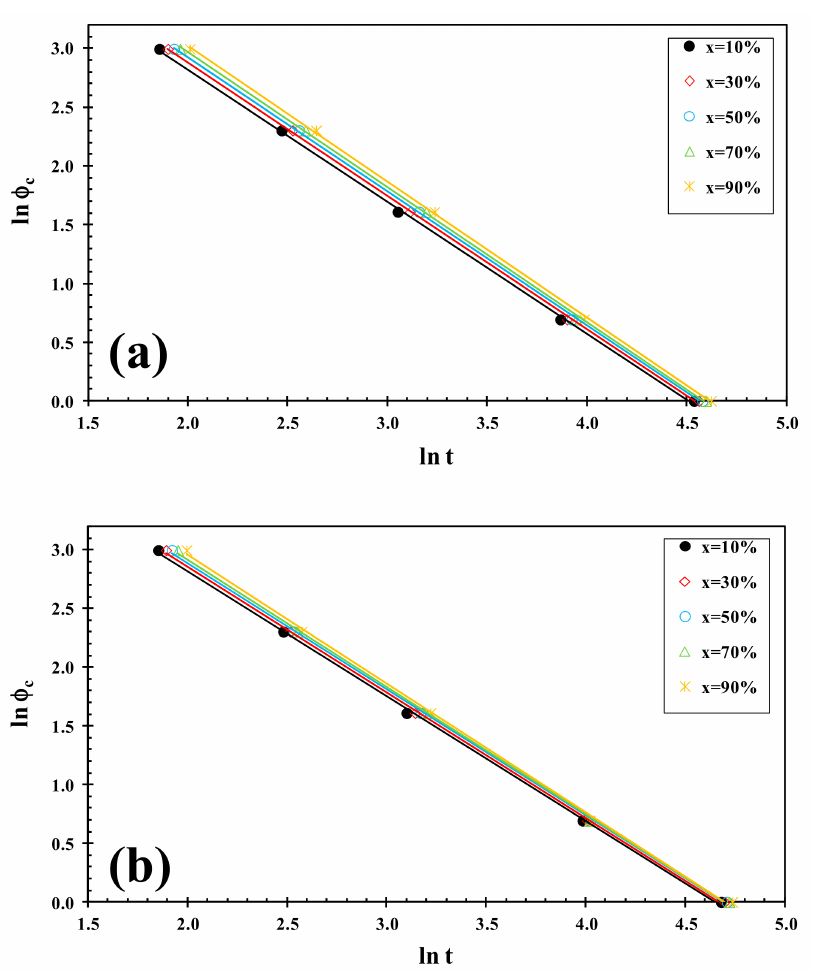
Figure 10. Liu plots for melt-crystallization of ( a ) PLLA and ( b ) PLLA/2D-WS 2 (0.5